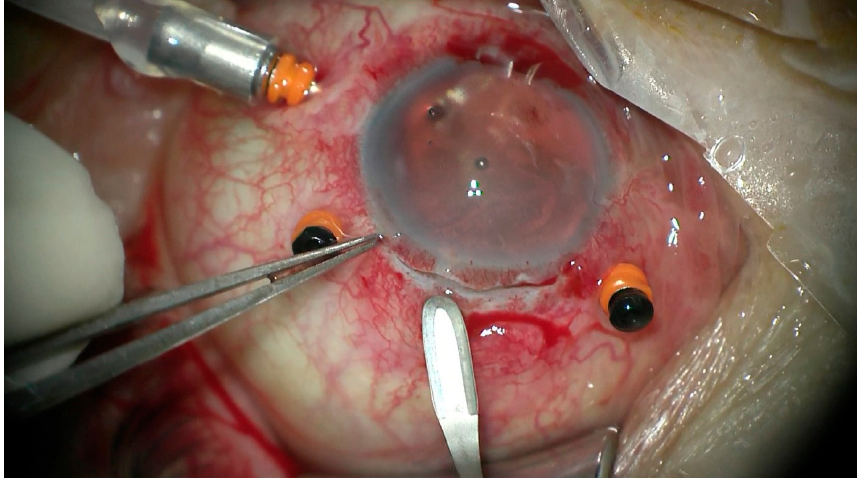
Figure 1. Creating a scleral tunnel 10 mm long after cutting the conjunctiva.